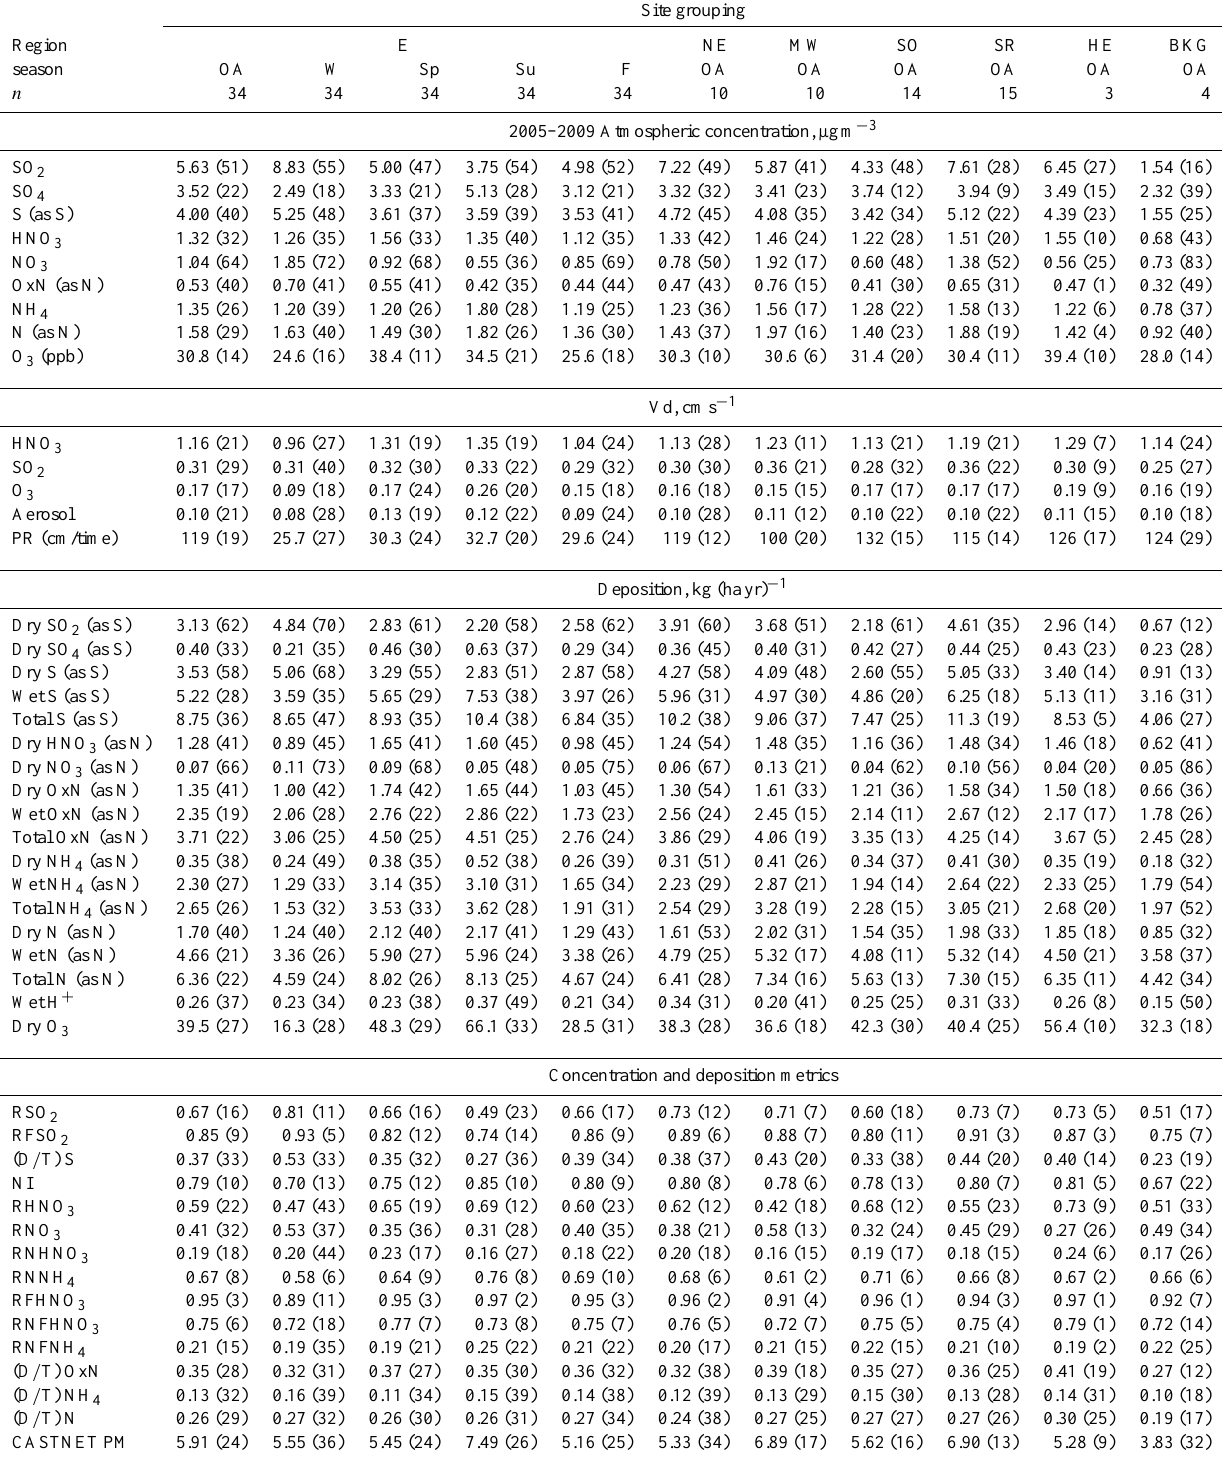
Table 3. Mean (CV) atmospheric concentration, deposition velocity, precipitation rate, dry, wet, and total deposition, and concentration and deposition metrics at 34 eastern US CASTNET and selected subsets of sites for the 5-year period 2005–2009 (see Table 2 for